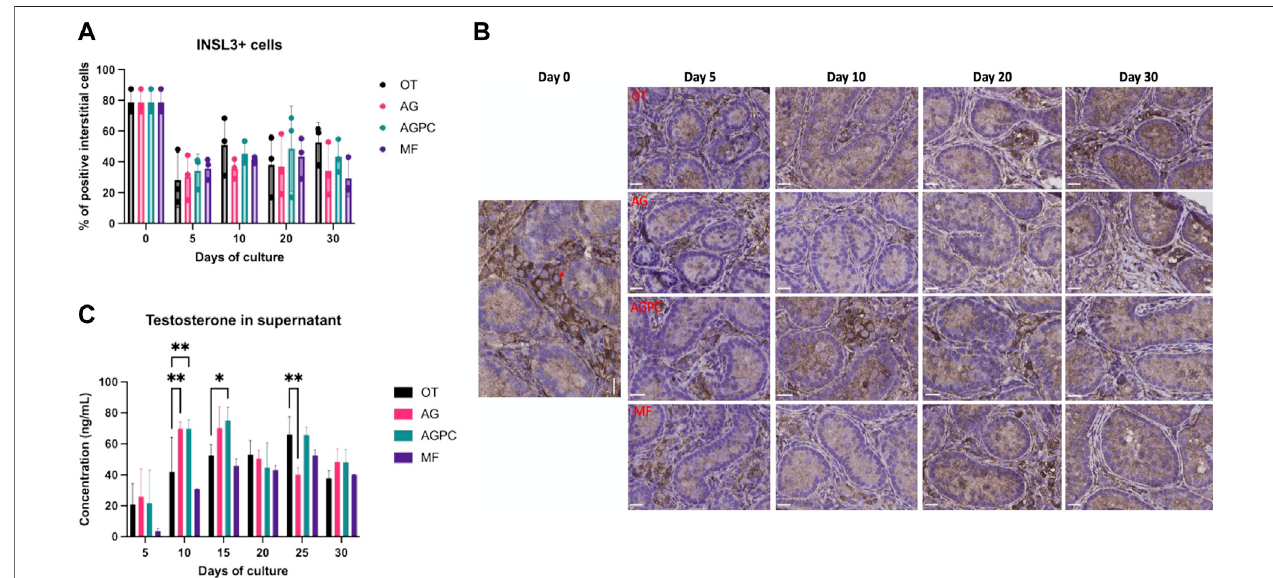
FIGURE6| EvolutionofLeydigcell numbers andfunctionover thecultureperiod. (A) Evolution ofthepercentageofINSL3+interstitial cellsoverthe cultureperiod. (B) INSL3 staining on immunohistochemistry. Red arrow shows a positive cell. (C) Evolution of testosterone secretion over the culture period. OT, culture insert PTFE; AG, Agarose; AGPC, Agarose + PDMS cover; MF, Micro fl uidic. Images shown at ×400 magni fi cation, Scale bars = 20 μ m.